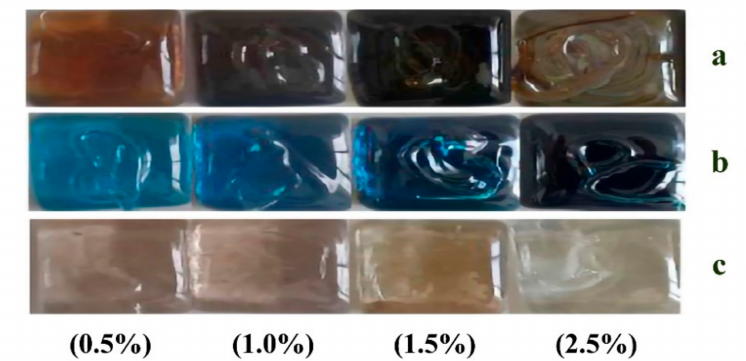
Figure 1. Glass samples containing ( a ) silver (I) oxide, ( b ) copper (II) oxide, and ( c ) strontium